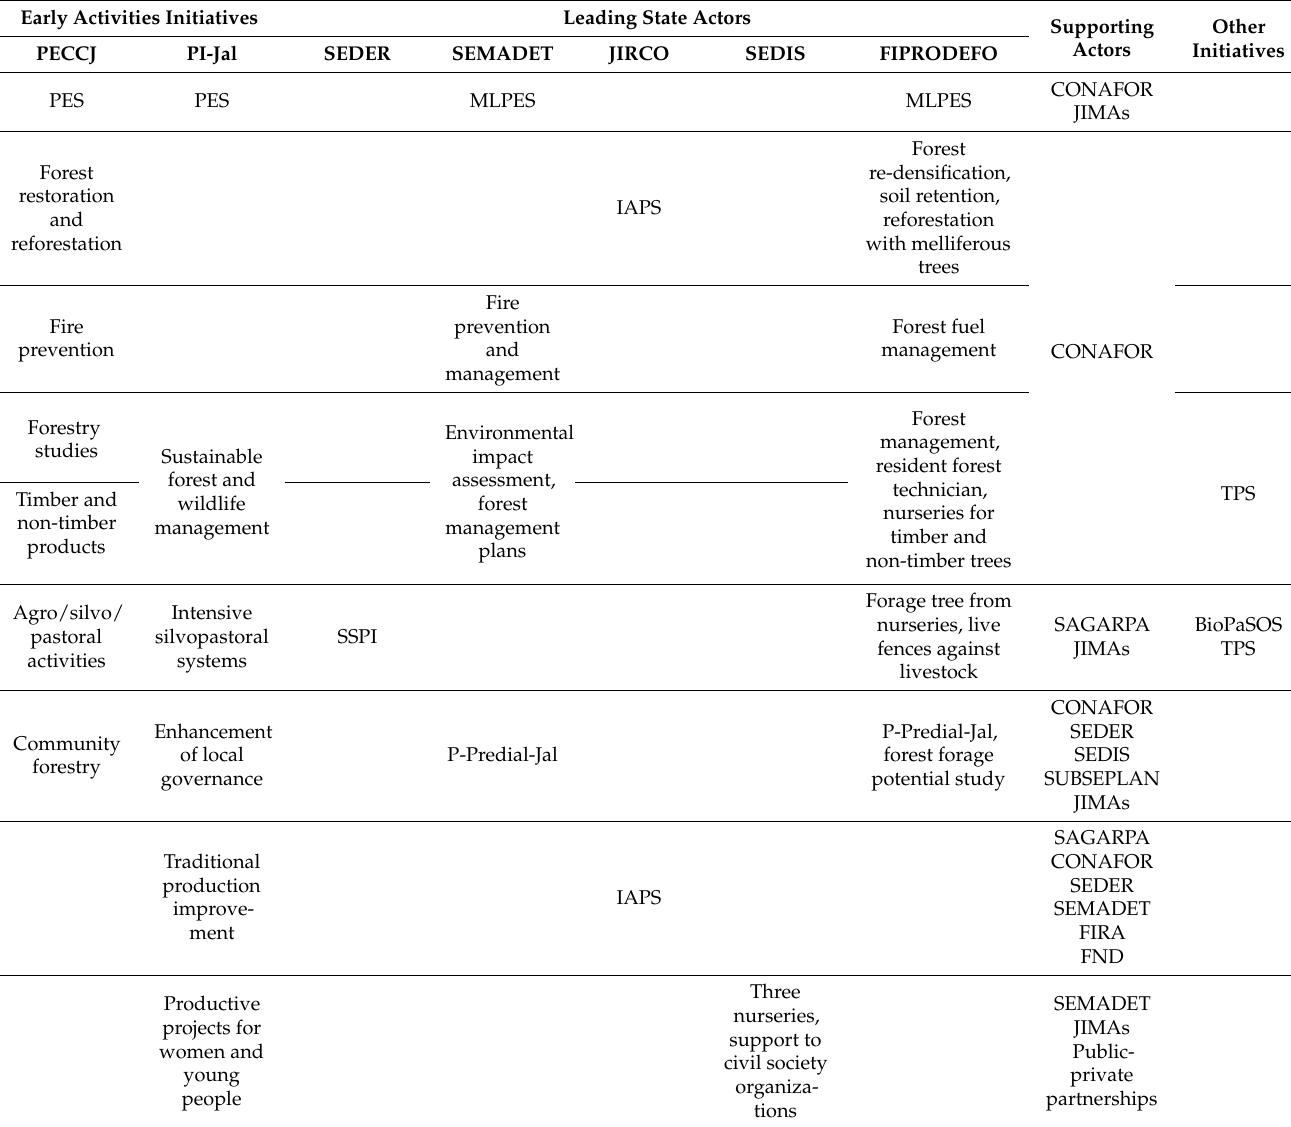
Table 3. The state government REDD+ related programs and activities and IRE-aligned initiatives in Jalisco. Early Activities